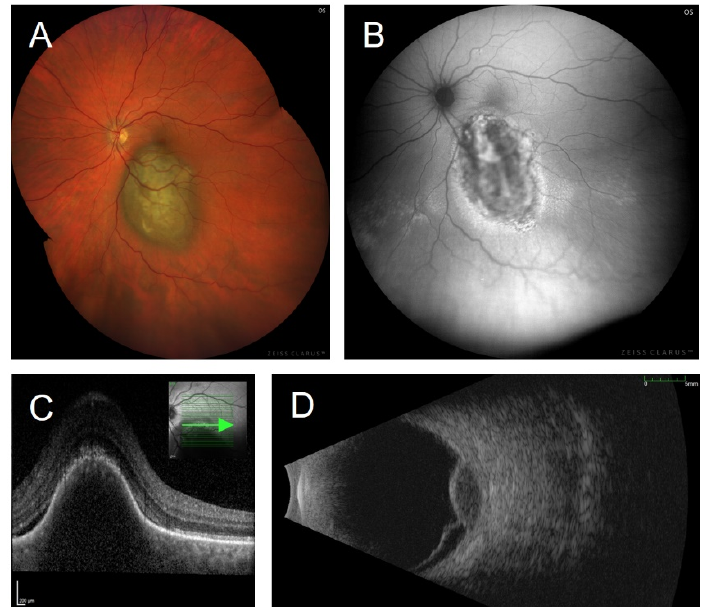
Figure 1. Multimodal imaging of a choroidal melanoma in a 51-year-old male patient presenting with metamorphopsia. Visual acuity was 20/20. ( A ) The fundus photograph shows a pigmented lesion (diameter > 5 mm) with overlying orange pigment, and ( B ) with marked changes of the signal seen on fundus autofluorescence (illumination with 500–585 nm, FAF-Green). Areas of intensely increased fundus autofluorescence alternate with areas of decreased fundus autofluorescence, reflecting a pronounced retinal pigment epitheliopathy, the presence of orange pigment, and subretinal fluid. ( C ) An OCT scan at the tumour’s margin shows a subretinal cleft due to malignant exudation. ( D ) Exudation is also seen on ultrasonography as exudative retinal detachment. The prominent tumour (height 3.6 mm) exhibits acoustic hollowness as a sonographic hallmark of choroidal melanomas. Images were taken using ( A , B ) the ZEISS CLARUS 700 (Carl Zeiss Meditec AG, Jena, Germany), ( C ) the SPECTRALIS OCT (Heidelberg Engineering, Heidelberg, Germany), and ( D ) Eye Cubed TM (Ellex Inc., Minneapolis, MI, USA).